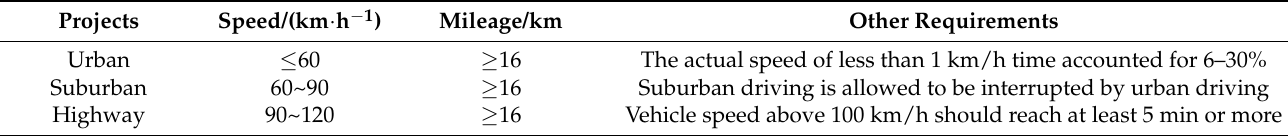
Table 4. RDE test conditions parameters.